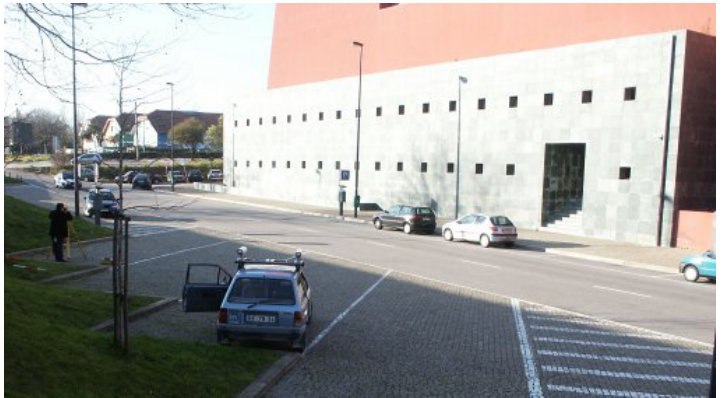
Figure 10. Total station survey for tests in relative coordinates and distances.